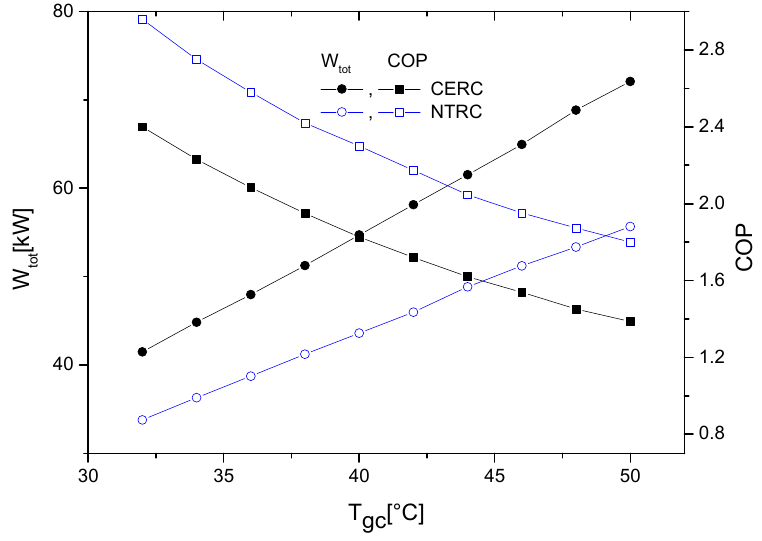
Figure 8. The COP and W tot variation as a function of T gc .